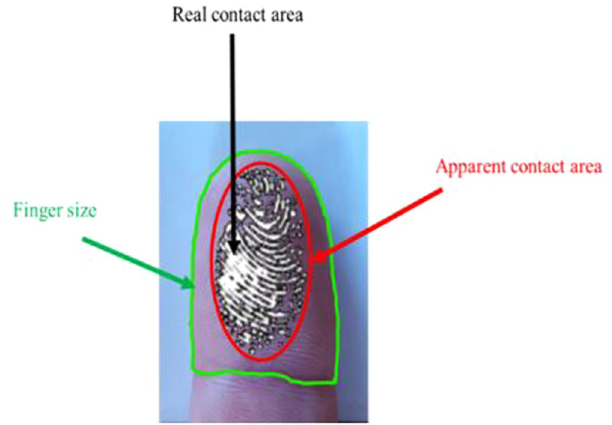
Figure 1. Illustration of the areas measured (finger size (green), apparent (red) and real contact areas (black)).